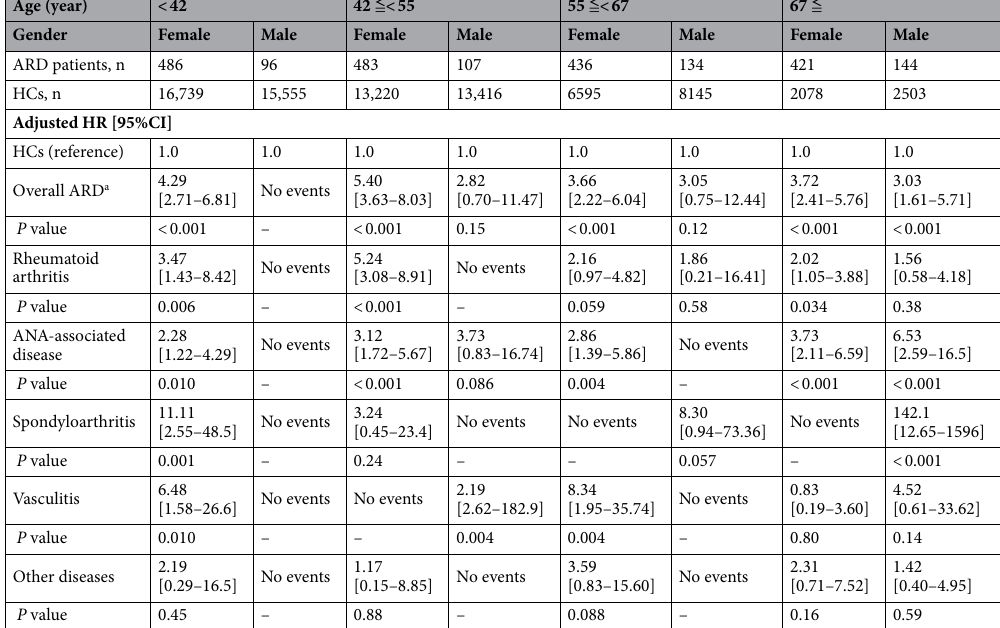
Table 5. Hazard ratio of autoimmune rheumatic disease for the development of hypothyroidism requiring treatment during follow-up stratified by age and sex. Patients were stratified based on gender and quartiles of age of ARD patients. ARD autoimmune rheumatic disease, HR hazard ratio, CI confidence interval, ANA antinuclear antibody. a Adjusted for age and baseline thyroid-stimulating hormone